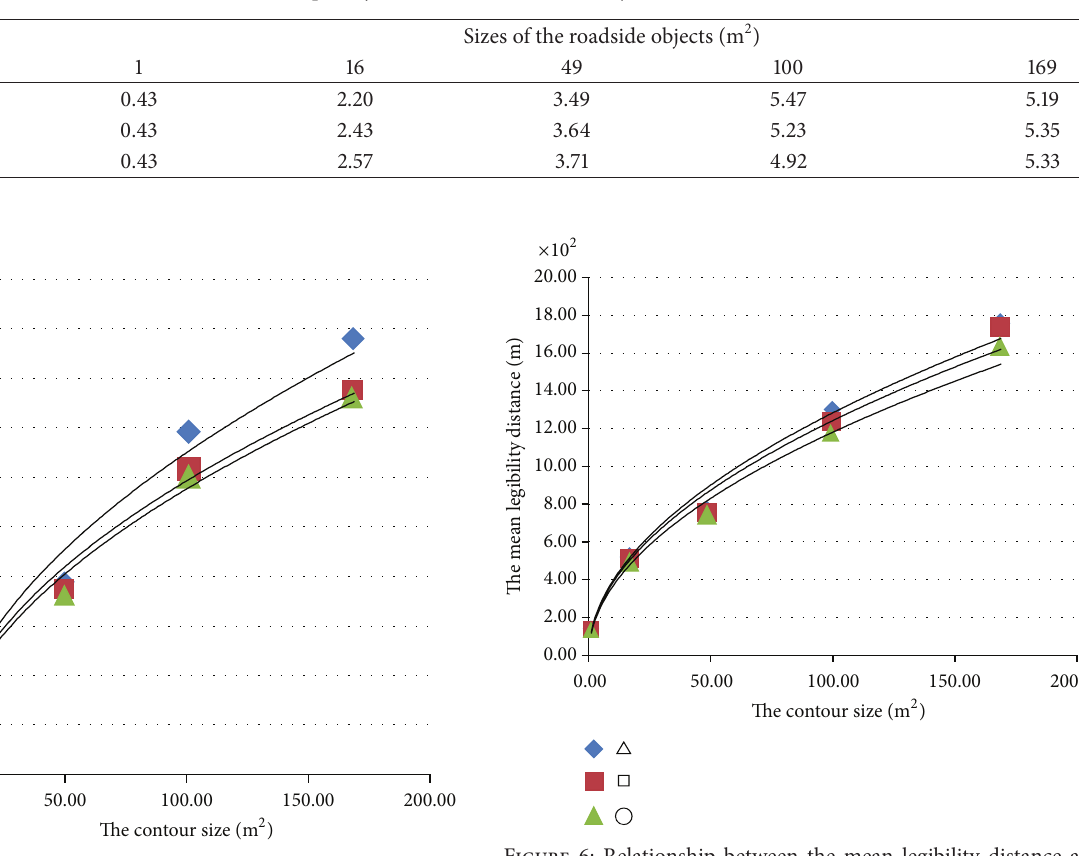
Table 9: The conspicuity assessment scores of the objects under 120km/h.